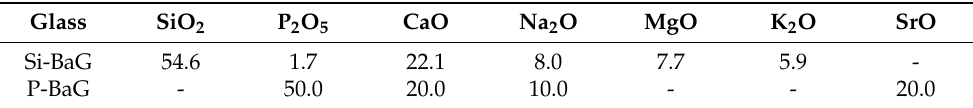
Table 1. Compositions of the bioactive silicate-based (Si-BaG) and phosphate-based (P-BaG) bioactive glasses in mol%.